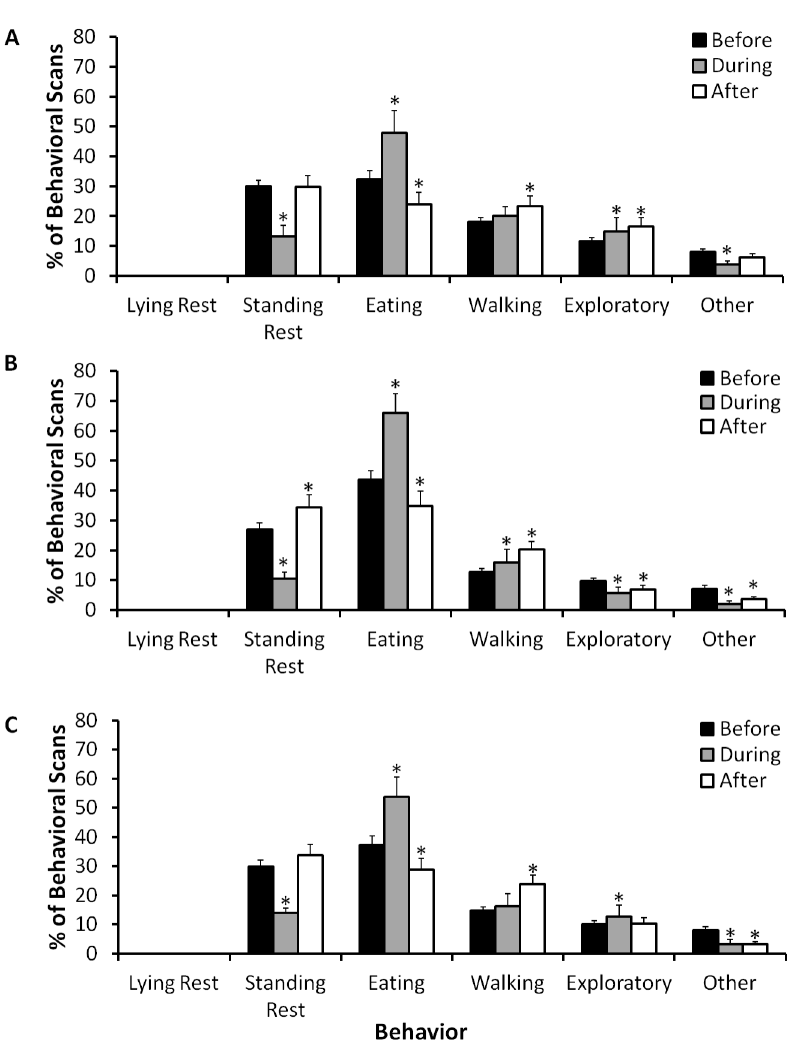
Fig 2. Diurnal outdoor activity budgets (mean ± SE) of three female African elephants (A: Asali; B: Gina; C: Tyranza) before, during, and after installation of rubberized flooring in their indoor facilities. Outdoor behavioral data collection occurred from approximately 09:00 to 16:00 h. An asterisk ( * ) indicates that the mean value is outside the 95% confidence interval (CI) for the data before renovations.